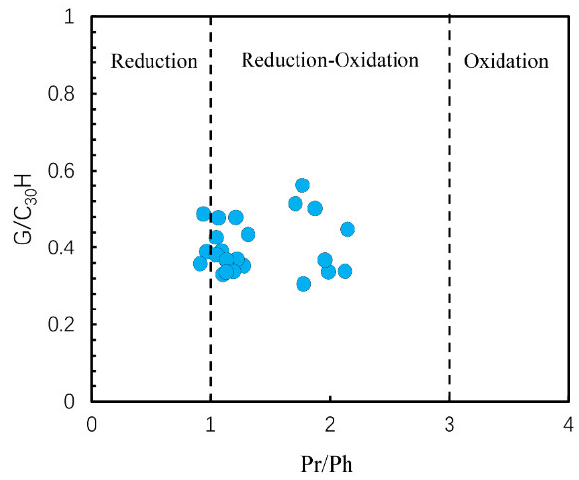
Figure 9. Diagram of G/C 30 H vs. Figure 10. Diagram of G/C 30 H vs. Pr/Ph.